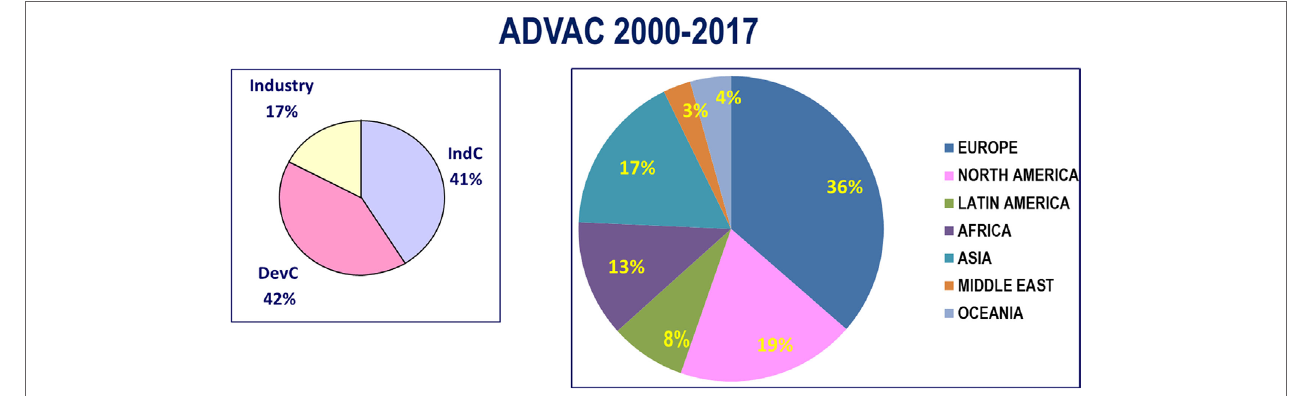
FiGURe 1 | Geographic distribution of ADVAC participants from 2000 to